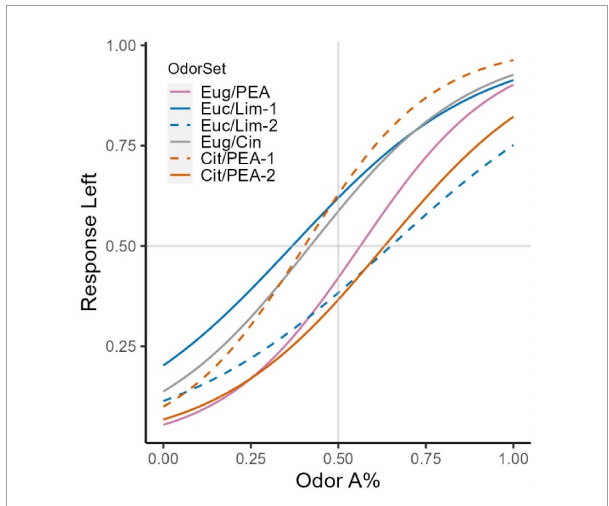
FIGURE3 Psychometric curve fits for all odor sets. A logistic model was fit to each odor set’s response intensities. Subgroups identified for OS2 and OS4 based on bimodality tests are treated as separate groups. For those groups, solid curves indicate the subgroup with more subject numbers (OS2 larger group: n = 6, smaller group n = 4; OS4 larger group n = 6, smaller group n = 2). Larger differences in trigeminal profiles do not produce larger overshadowing effects. OS1 (Eug/PEA) and OS4 (Cit/PEA) do not produce more